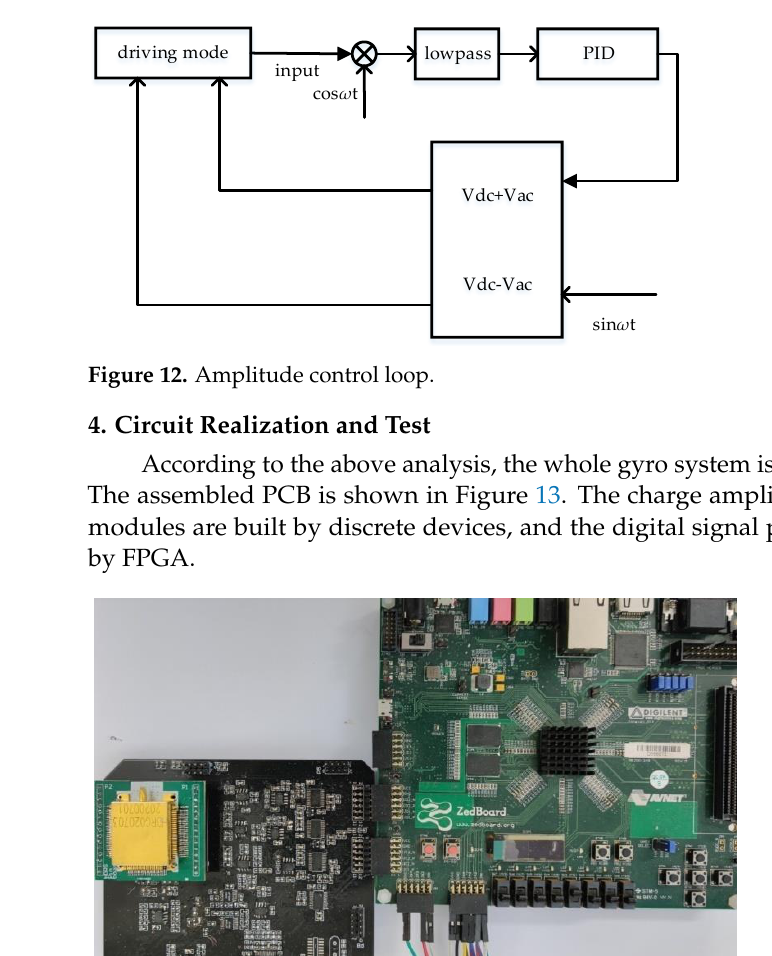
10 of 15 Figure 11. Control system of quick start driving loop. 3.3. Control System of Amplitude Stable Loop Gyro control system needs amplitude control loop to avoid change of amplitude